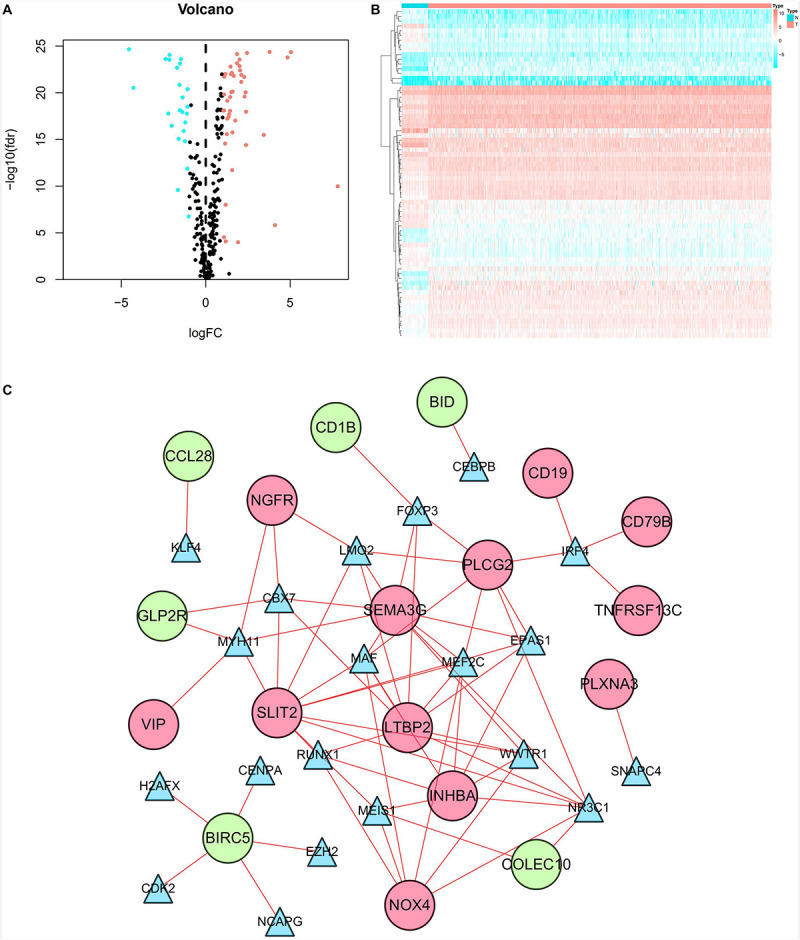
TF regulatory network. (A) Volcano plot of differentially expressed TFs. The salmon dots represent the upregulated TFs and the cyan dots represent the downregulated TFs in CRC. Black dots represent no statistical significance. (B) Heatmap of differentially expressed TFs. The progression from low to high expression of TFs is shown by the color from cyan to salmon. (C) Construction of the network with TFs and prognostic immune-related differentially expressed genes. The blue triangles, red circles, and green circles represent TFs, high-risk genes, and low-risk genes, respectively.